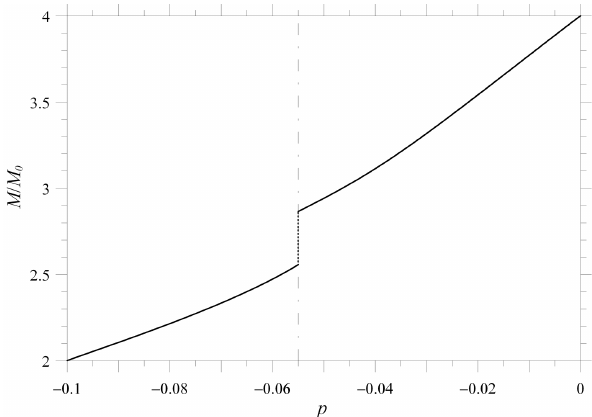
Fig. 7. Seismic moment release associated with simultaneous as- perity failure as a function of p ( (cid:15) = 0 . 7, α = 1). The discontinuity is at p =− c